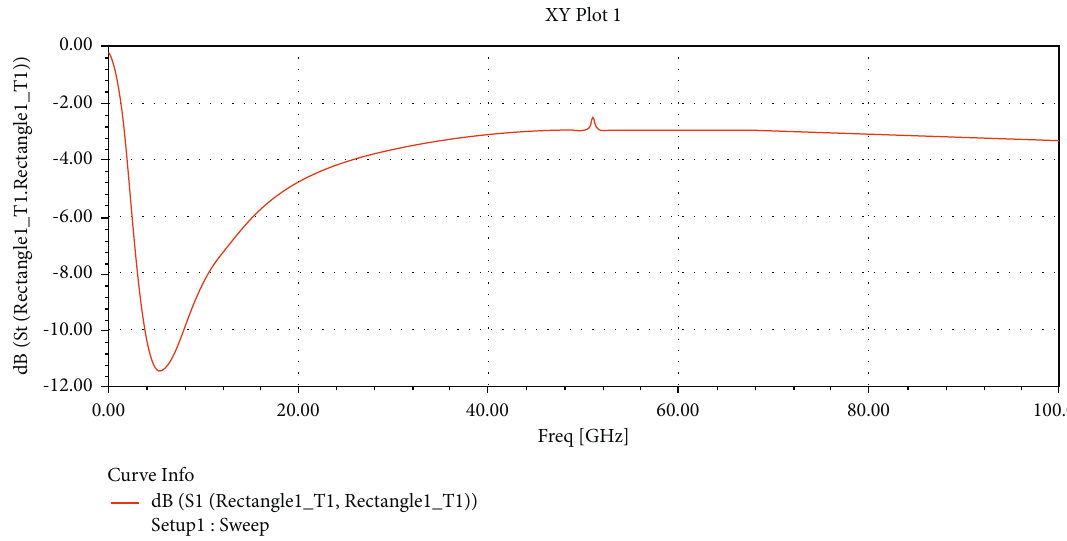
Figure 6: Resonant frequency of designed circular patch